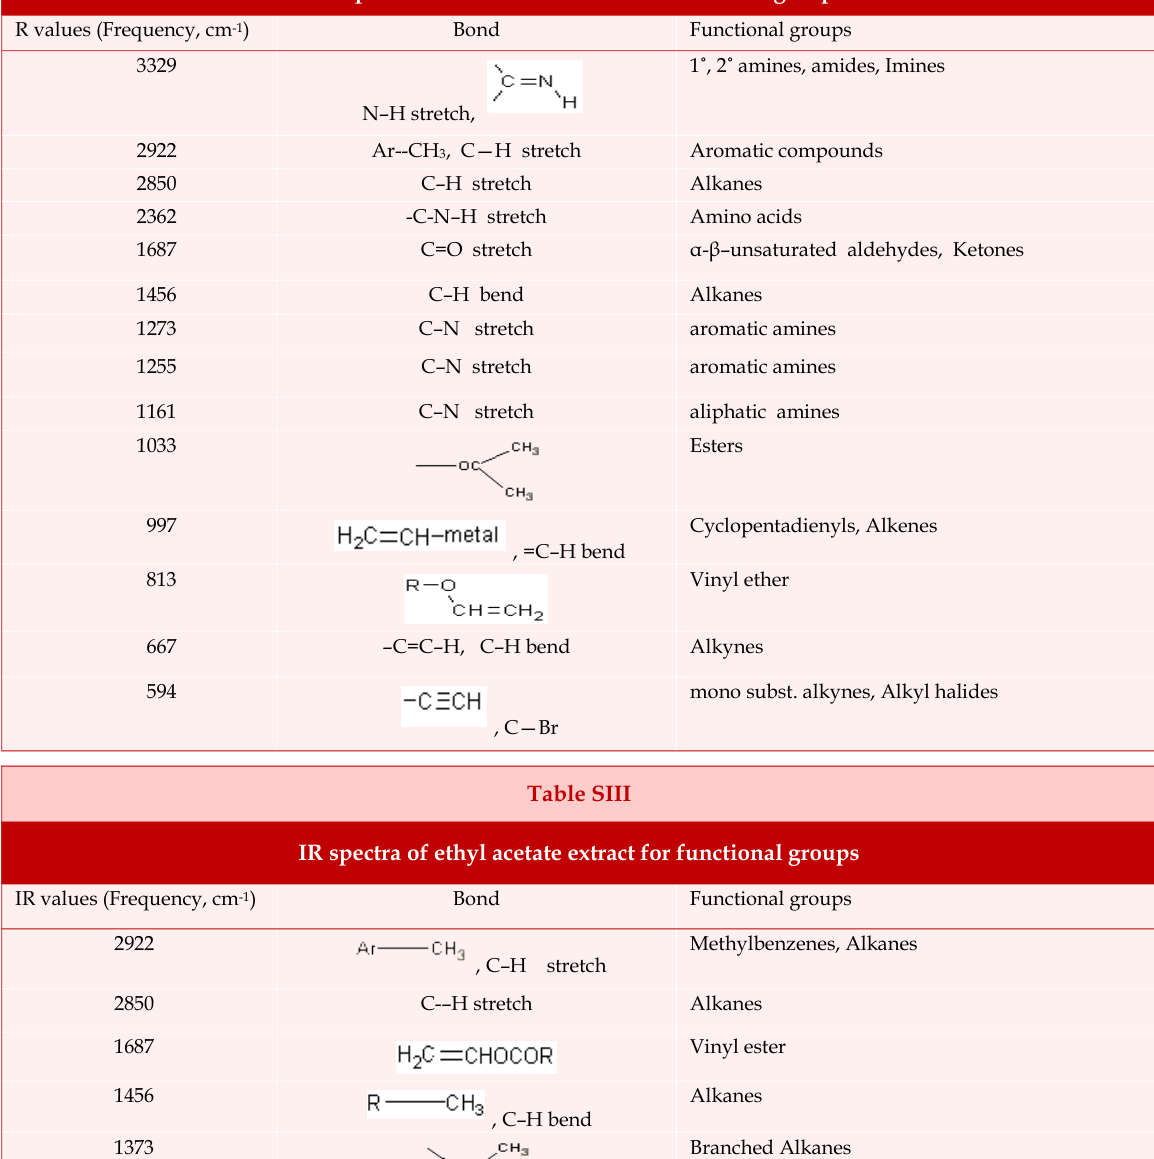
IR spectra of methanol extract for functional groups